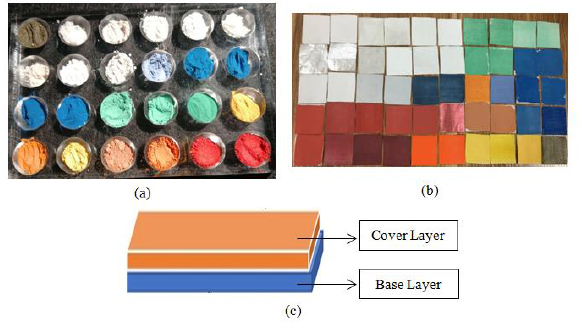
Figure 1. (a) some of no-glue powdered pigment